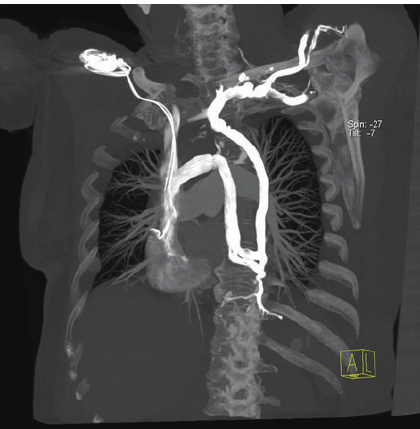
Figure 1: Reformatted CT angiography image shows the anomaly in the venous phase.